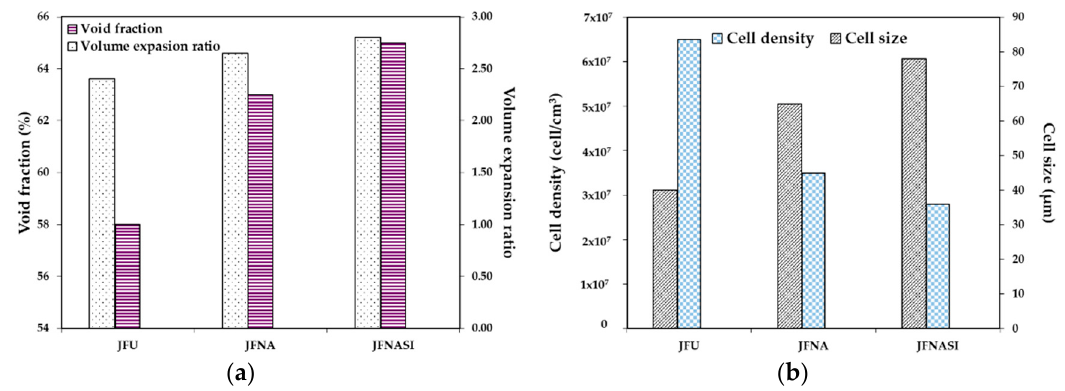
Figure 12. Effect of jute fiber surface treatment on the foam microstructure of the PLA/jute fiber biocomposites: ( a ) void fraction and expansion ratio ( b ) cell size and cell density. Data taken from Zafar et al. [128].